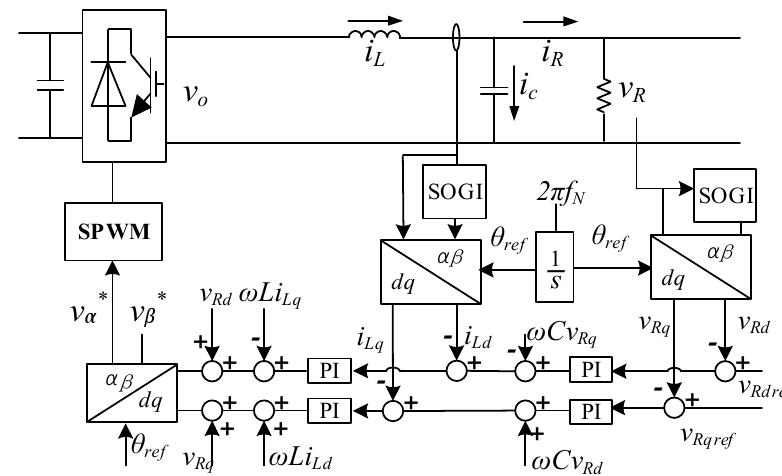
Figure 3. Block diagram of V/f control strategy for single-phase DC/AC bi-directional converter.